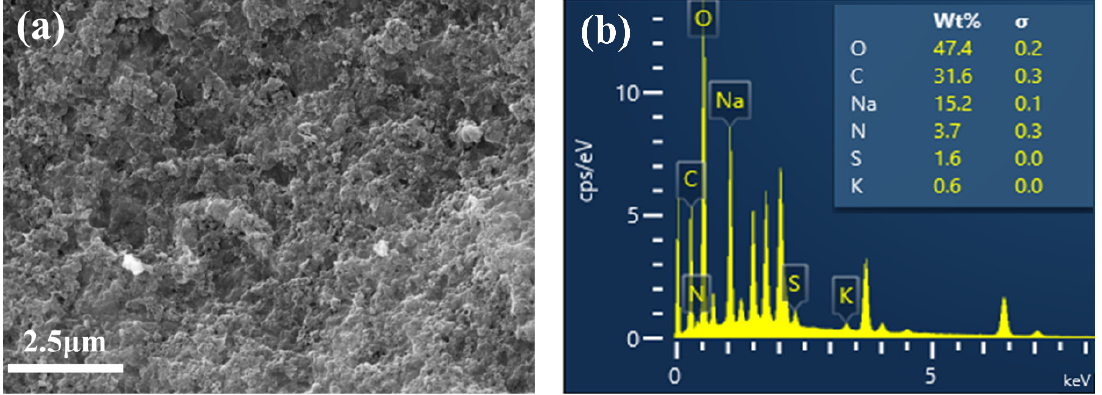
Figure 7. FTIR spectra of ( a ) raw sludge, thermal-alkaline pretreated sludge and s ludge with micro- Figure 7. SEM image ( a ) and EDS spectra ( b ) of the extracted crude wave combined with thermal-alkaline pretreatment; ( b ) extracted sugars from sludge with com- bined pretreatment and thermal-alkaline pretreatment.